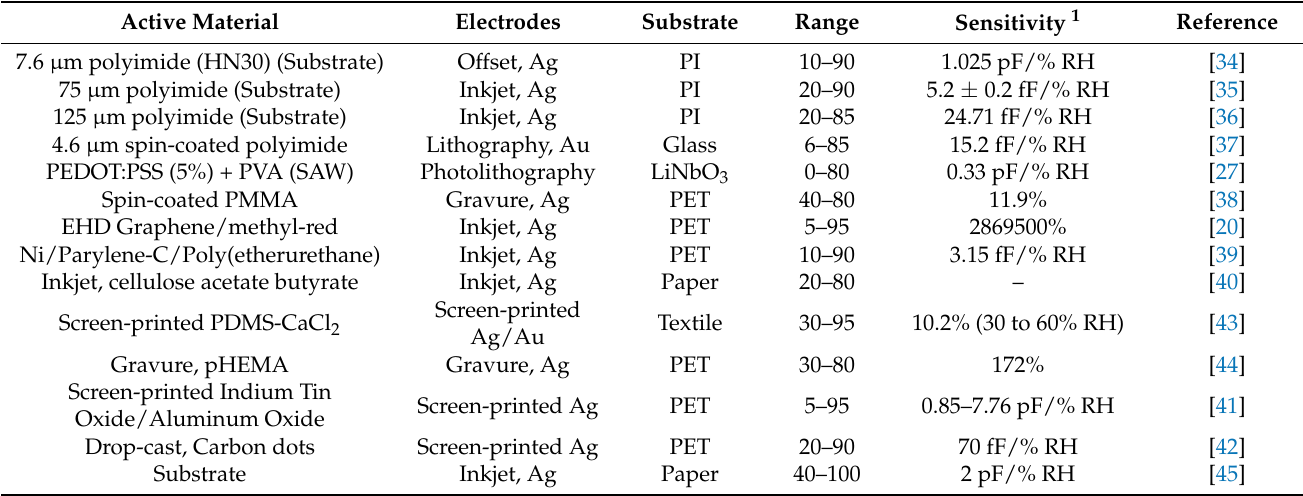
Table 3. Capacitive Humidity Sensors.